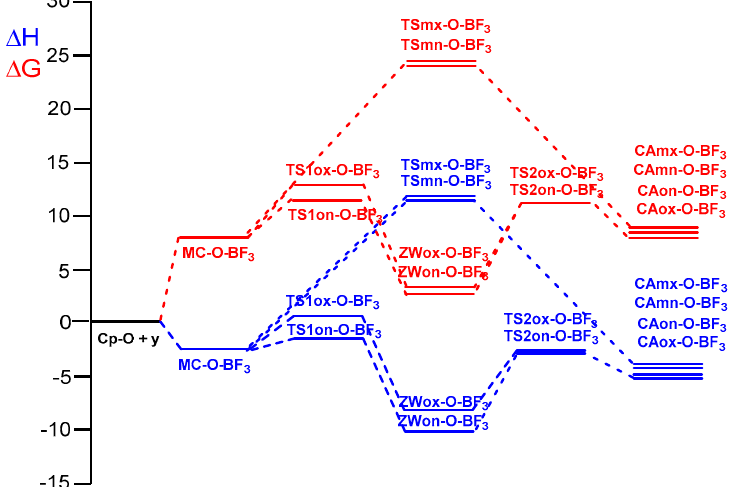
Figure 9. MPW95/6-311G(d,p) enthalpy, in blue, Δ H in kcal mol –1 , and Gibbs free energy, in red, Δ G Figure 9. MPW95 / 6-311G(d,p) enthalpy, in blue, ∆ H in kcal mol –1 , and Gibbs free energy, in red, ∆ G in in kcal mol –1 , profiles, in DCM at 25 °C, for the four competitive reaction paths associated to the P-DA kcal mol –1 , profiles, in DCM at 25 ◦ C, for the four competitive reaction paths associated to the P-DA reaction of Cp 13 with complex 7-BF . reaction of Cp 13 with complex 7-BF 3 3